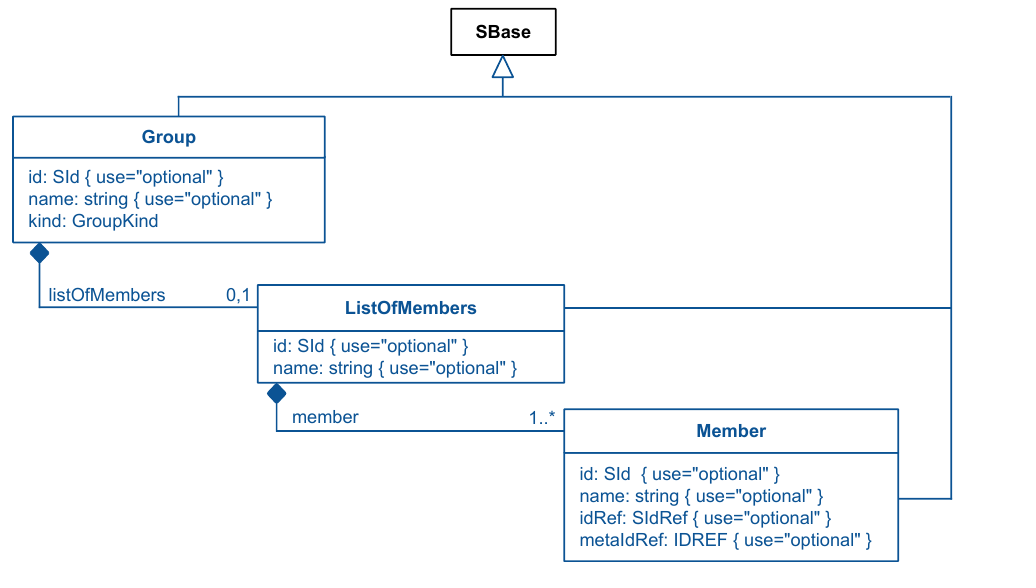
Figure 1: The definition of the Group , ListOfMembers , and Member